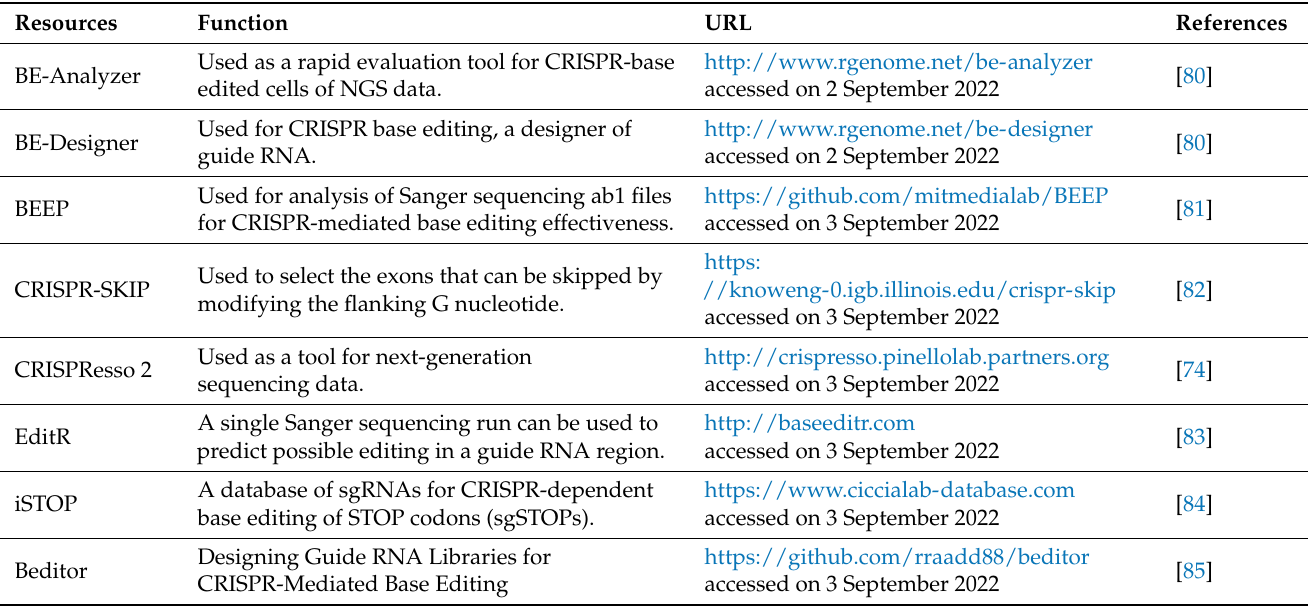
Table 2. Base editing